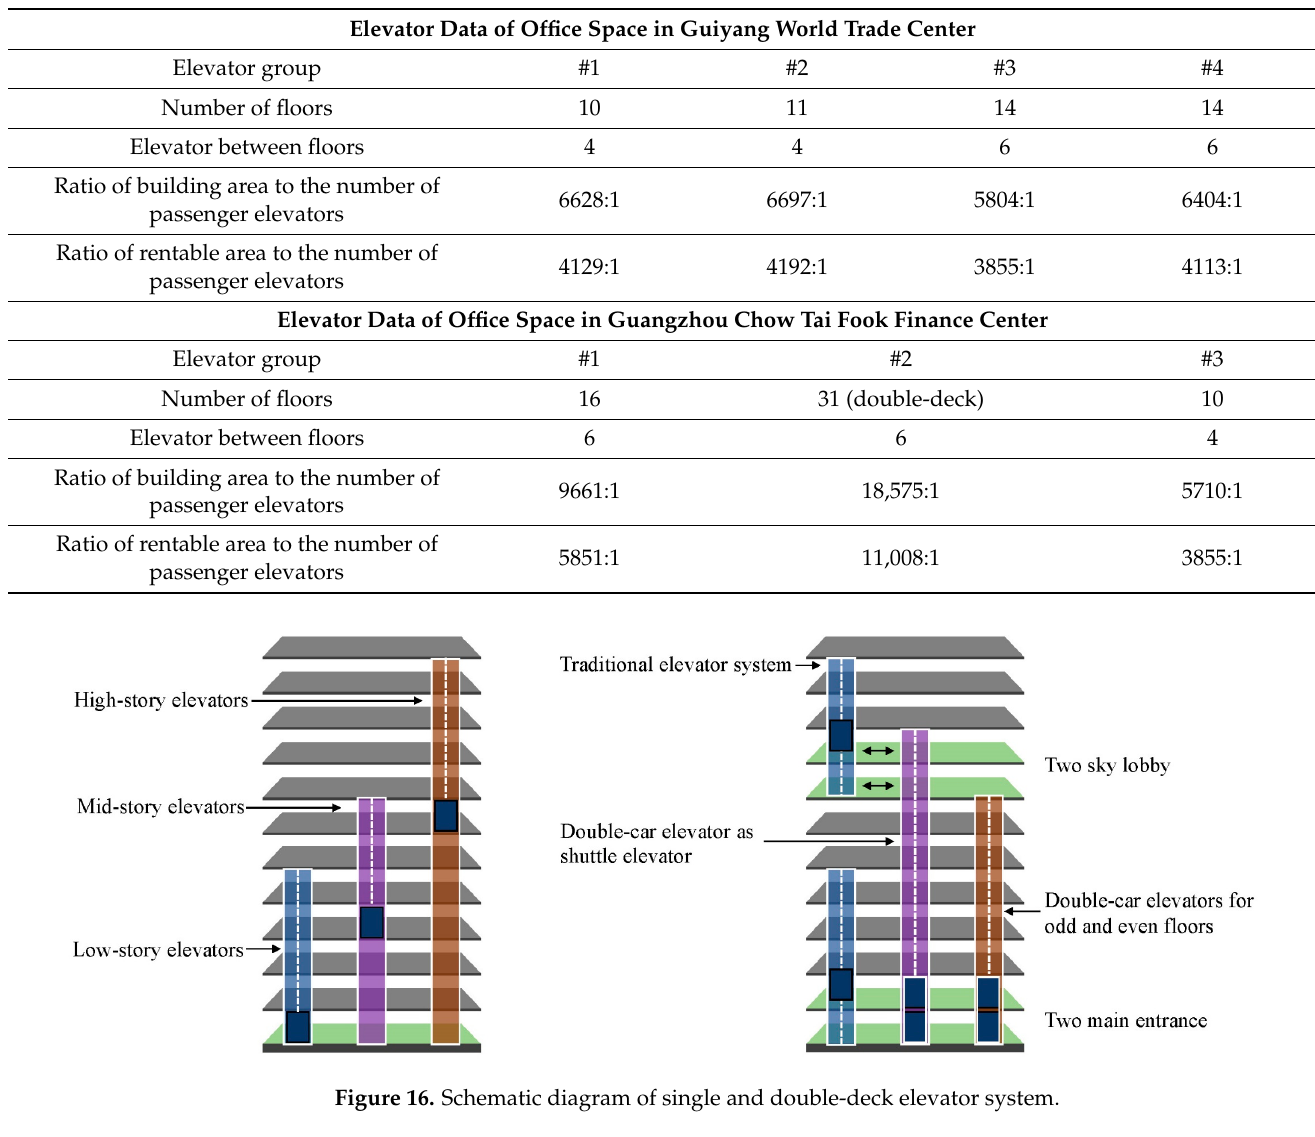
Table 6. Elevator data of office space in Guiyang World Trade Center and Guangzhou Chow Tai Fook Finance Center.